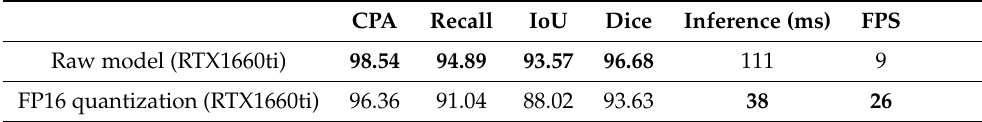
Table 5. Model quantification results.